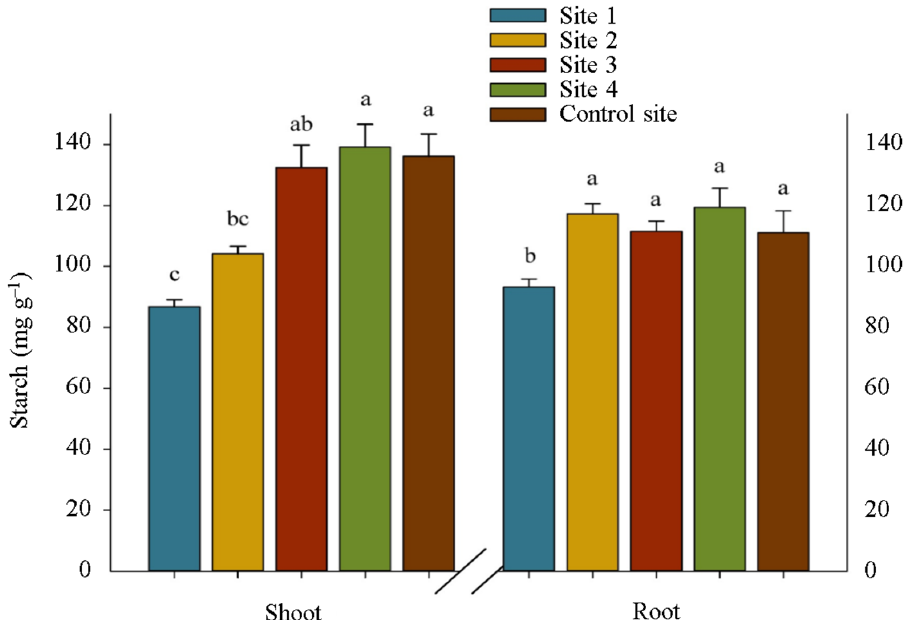
Figure 2. Starch content in the shoot and root of S. portulacastrum plants at different levels of heavy metals pollution. Means in each tissue followed by similar letter(s) are not significantly different at 5% probability level (Tukey’s HSD test).